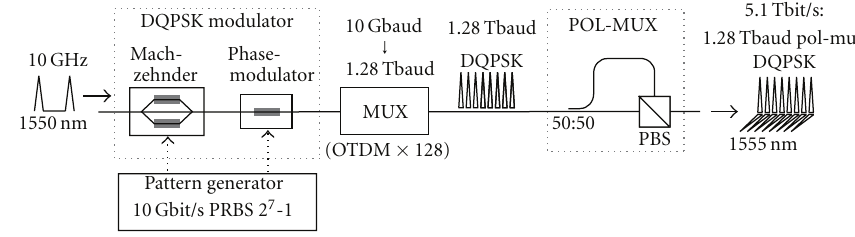
Figure 11: 5.1 Tbit/s data generation set-up.